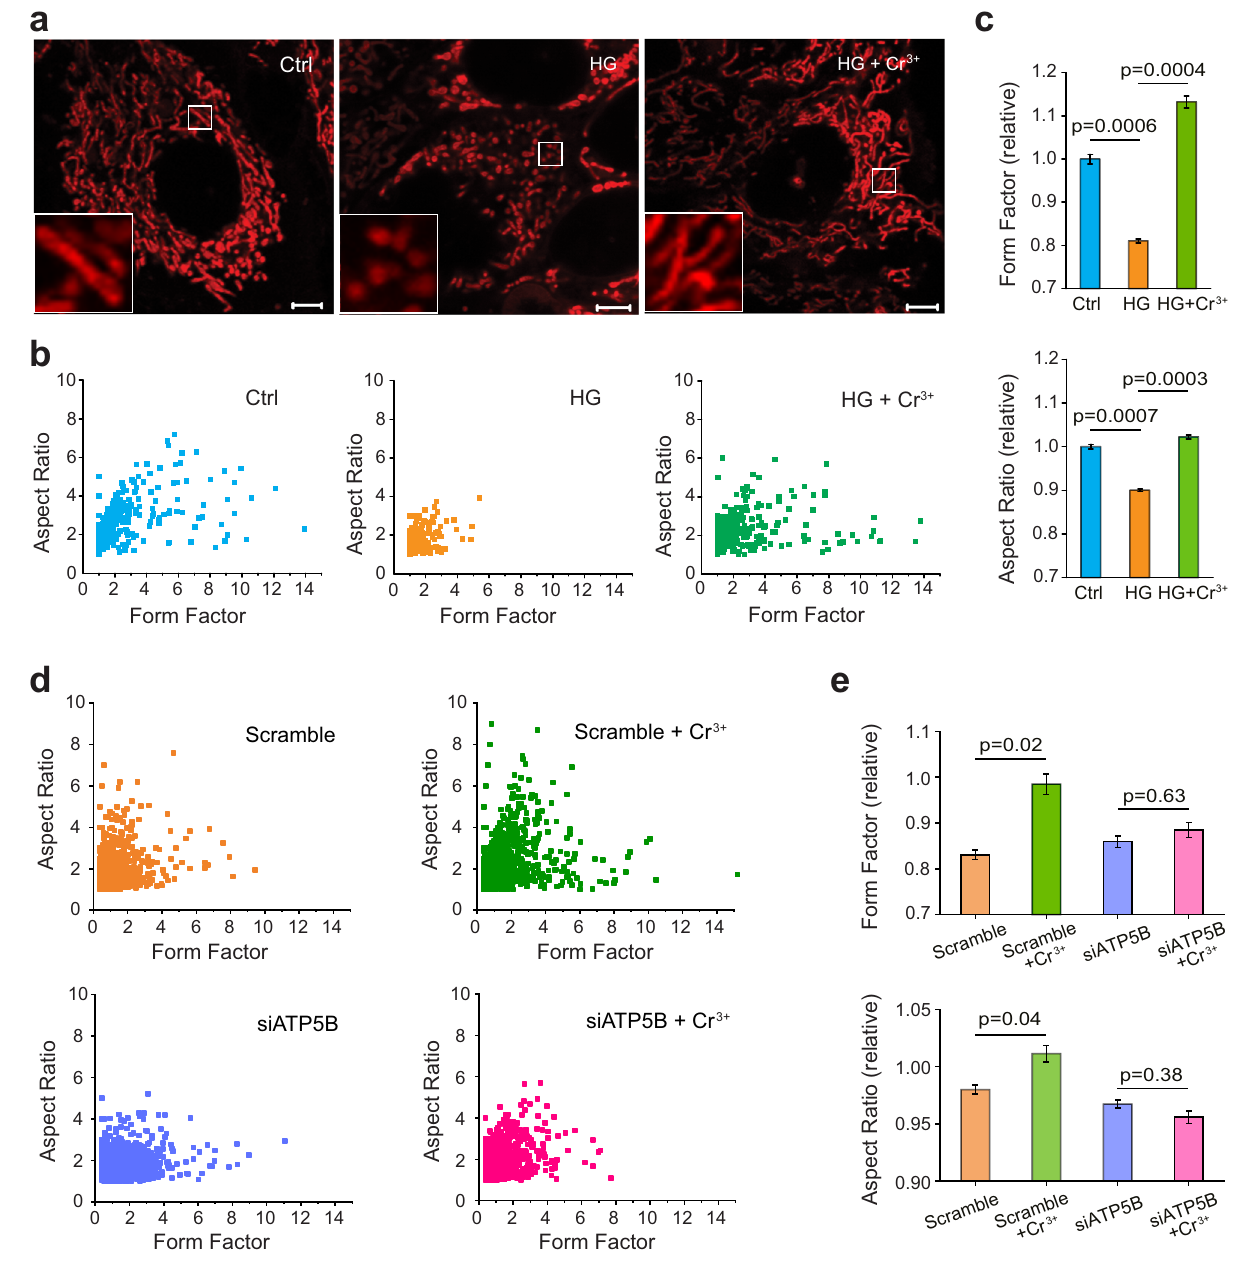
Fig.3|Cr 3+ rescuesmitochondriafromhyperglycaemia-inducedfragmentation through targeting ATP5B. a Representative microscopic imaging of HepG2 cells with mitochondria stained by MitoTracker under normal glucose condition (5.6mM, as Ctrl), high glucose-induced stress (40mM, as HG) and high glucose- induced stress with Cr 3+ supplementation (100 µ M) (HG+Cr 3+ ) ( n =10). Inset : 4 timesenlargementofmitochondria.Scalebars:5 µ m. b , c Quantitativeanalysisand quanti fi cation of mitochondrial morphology illustrated by form factor (FF) and